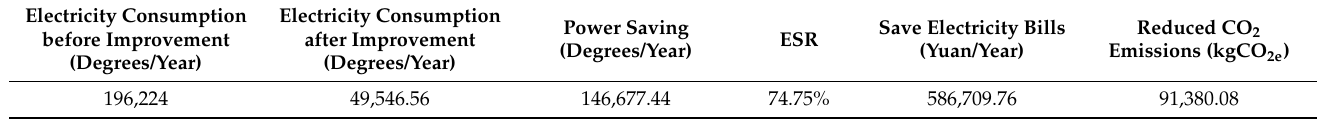
Table 4. Reduced electricity consumption, cost and carbon emissions of a farm during the same